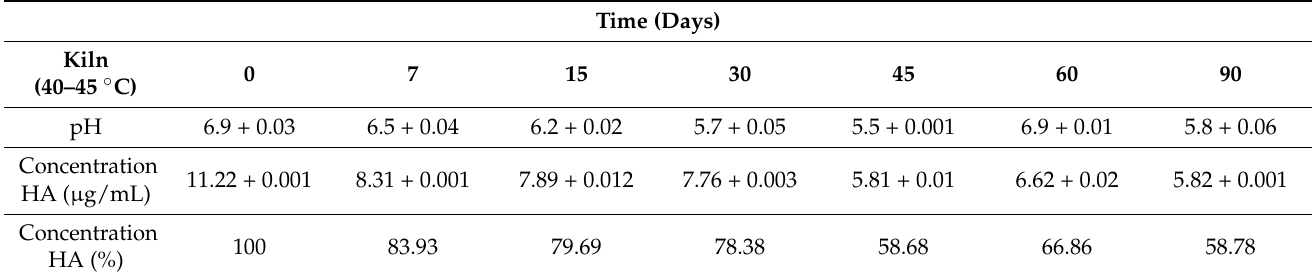
Table 3. Physicochemical characteristics of OG + HA stored at kiln temperature for 90